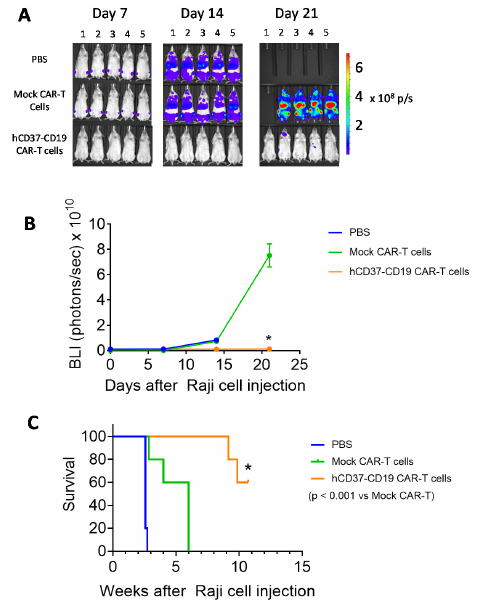
Figure 5. hCD37-CD19-CAR-T cells significantly block Raji xenograft tumor growth in vivo . ( A ). In vivo imaging of Raji tumors in mice on days 7, 14, and 21 following Raji-Luc+ cells injection